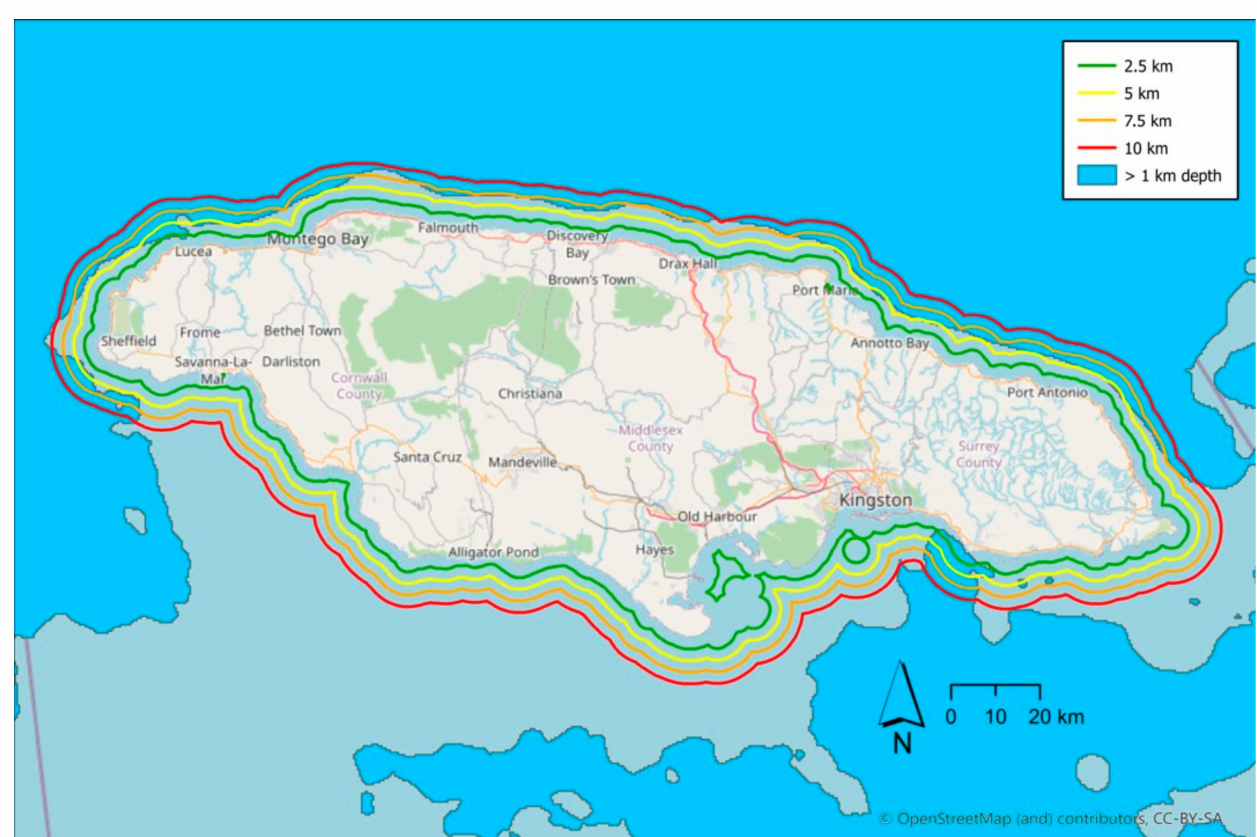
Figure 2. Map of Jamaica with a bathymetry contour representing the boundary between depths of greater than 1000 m (blue) and less than 1000 m (gray). Other contours are equidistant from the coast at 2.5 km (green), 5.0 km (yellow), 7.5 km (orange) and 10 km